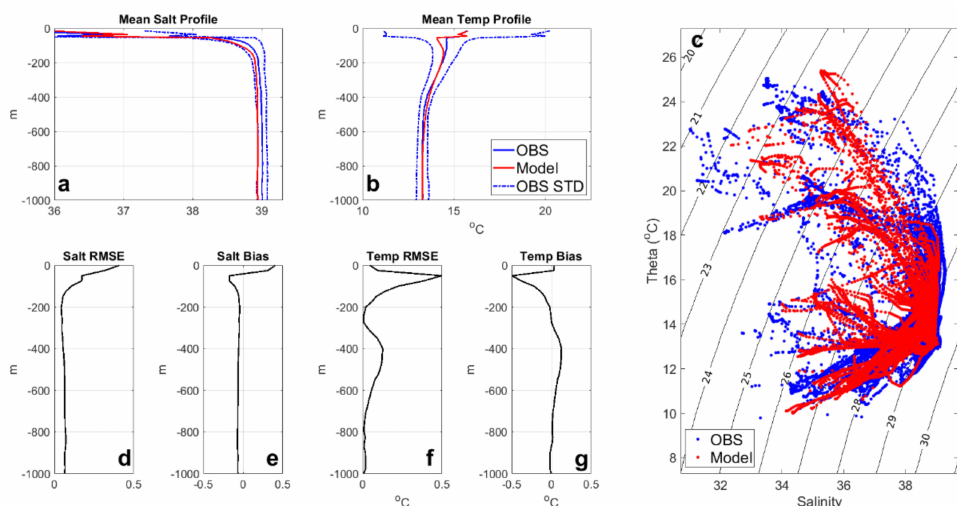
Figure 11. Hydrographic properties of north Lemnos basin. Panels ( a , b ) are the mean salinity and temperature profile from the surface to 1000 m depth, respectively. Model output is given with a red solid line, observations with a blue solid line and the standard deviation with a dashed blue line. Panels ( d – g ) is the mean profile error—RMSE and Bias—estimation for the tracer. Finally, at panel ( c ) is the θ /S diagram for all observations (blue dots) and the corresponding model data (red dots).